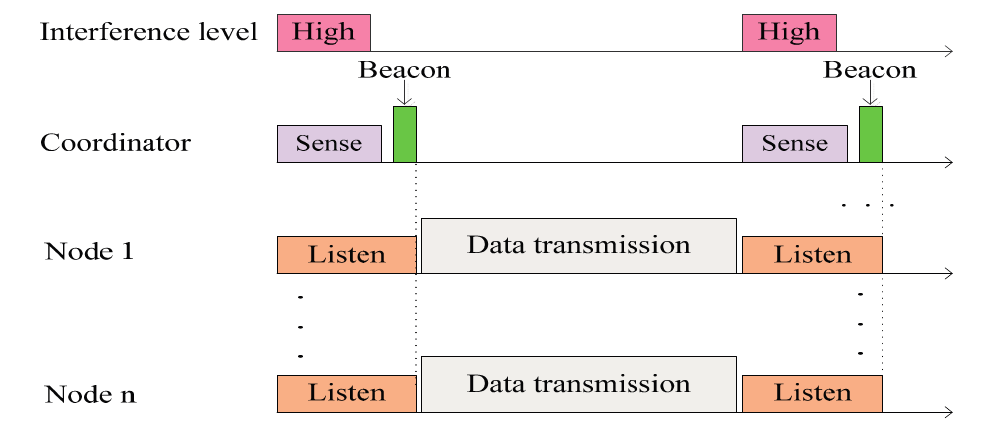
Figure 7. System architecture of hybrid cognitive validation platform (HCVP).